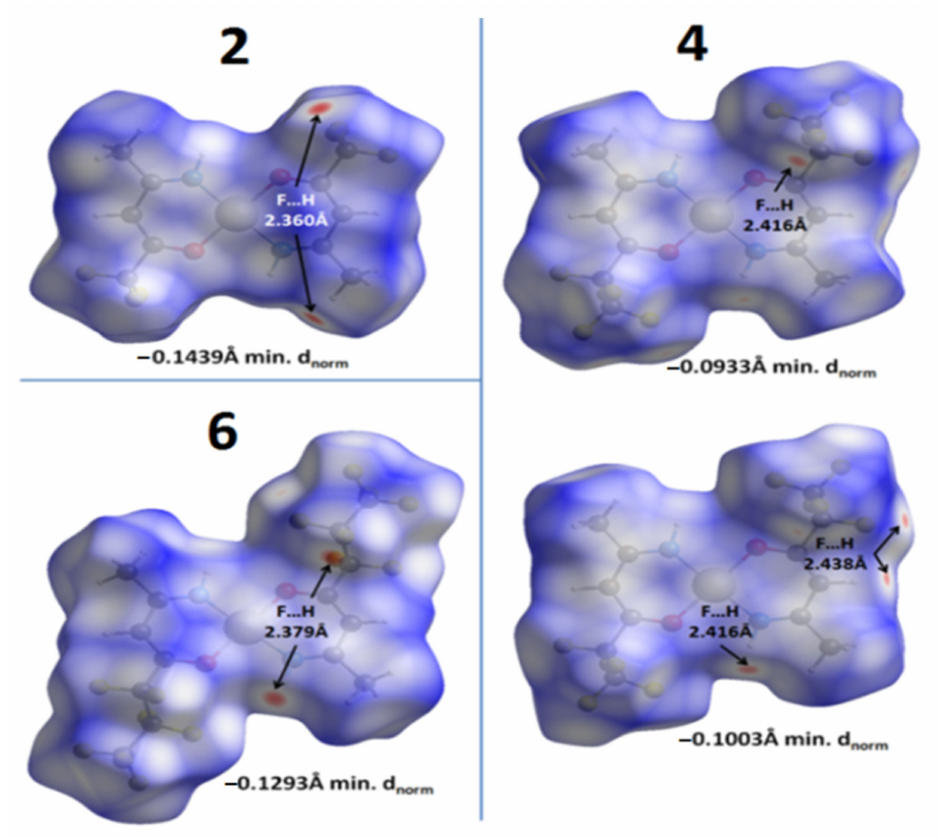
Figure 6. Hirshfeld surfaces for Pd β -iminoketonates, mapped with the d norm property (range − 0.18 to